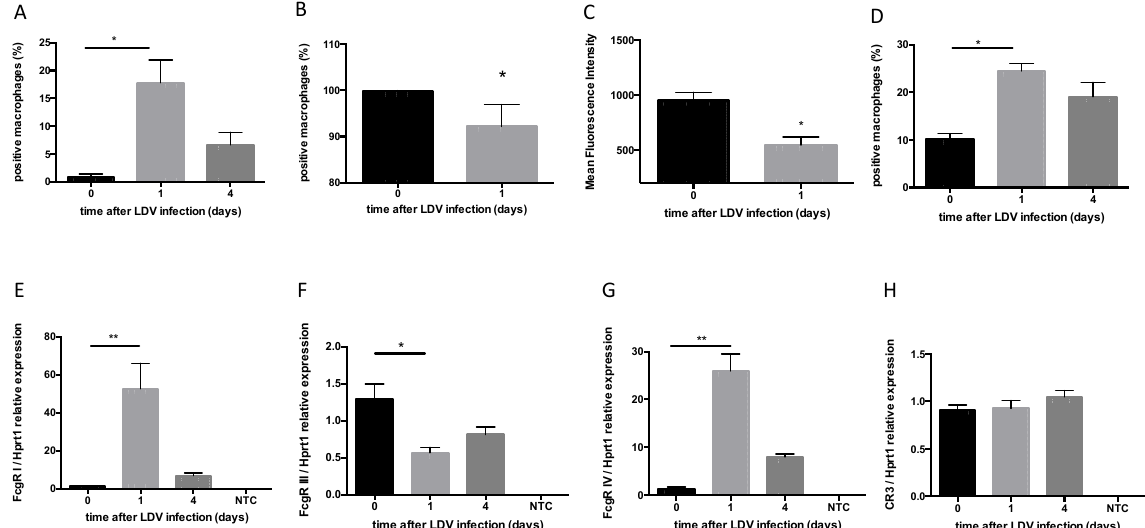
Figure 3. Modulation of activating Fc γ receptors and of CR3 expression after LDV infection. ( A – D ) The CD11b+ F4/80+ peritoneal macrophages of 4 mock- or LDV-infected C57BL/6 were stained with either anti-Fc γ R I ( A ), anti-Fc γ R III ( B , C ), or anti-Fc γ R IV ( D ) antibodies. ( E–H ) Fc γ ( E – G ) and C3 ( H ) receptor gene expression in CD11b+ F4/80+ peritoneal macrophages from groups of 4 mock- or LDV-infected C57BL/6 were assessed by RT-qPCR. The results are shown as the means ± SEM. NTC: negative control. * p < 0.05, ** p <